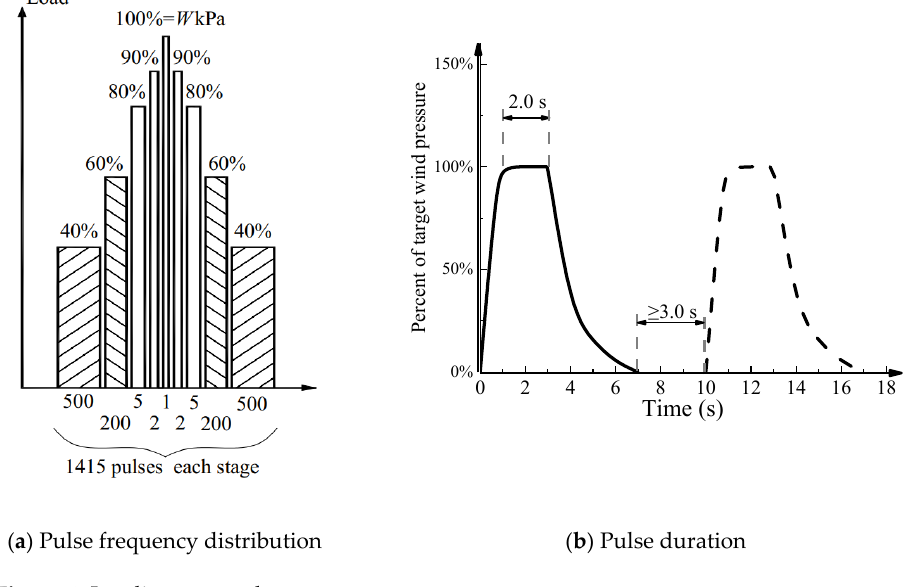
Figure 4. Loading protocol. Table 1. Calculation coefficients corresponding to different heights.